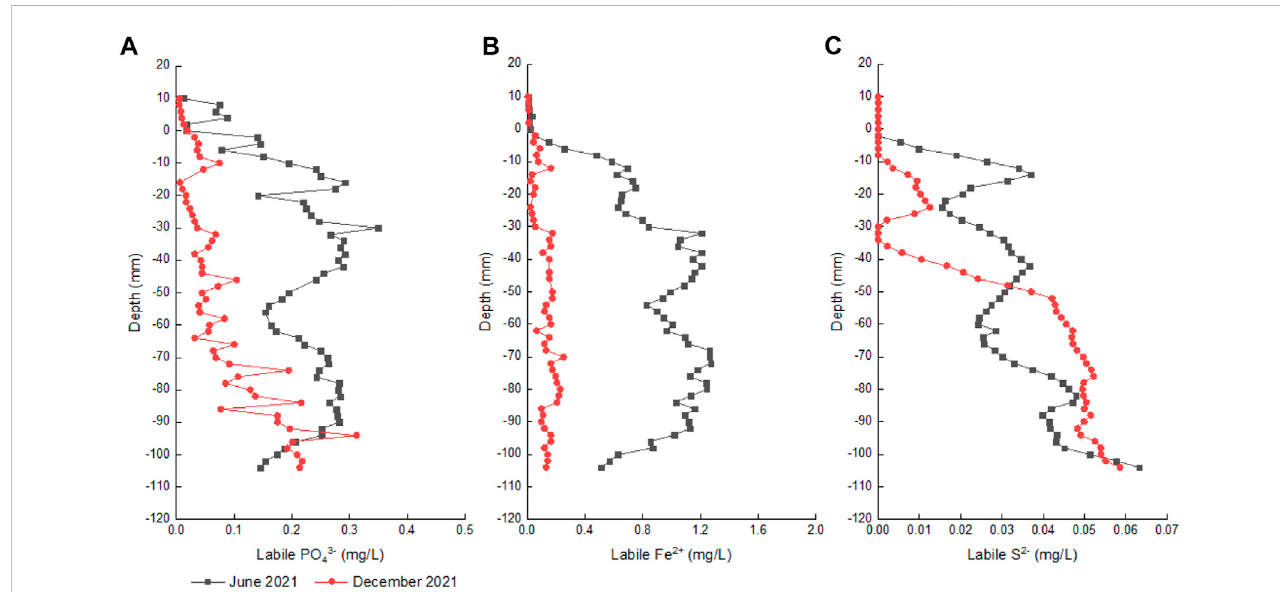
FIGURE 4 Concentrations of labile PO 4 3- , Fe 2+ and S 2- in the sediment cores in the two periods. (A-C) represent labile PO 4 3- , Fe 2+ and S 2- ,